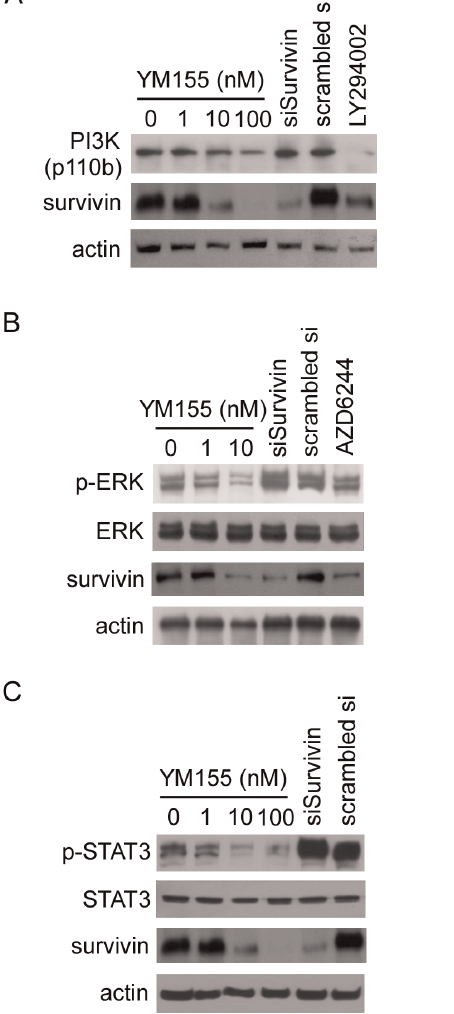
Figure 2. YM155 induces downregulation of PI3K, p-ERK, and p-STAT3 in PANC-1 cells. A, Levels of PI3K and survivin were analyzed by Western blotting after treating with YM155 or 30 m M LY294002 (control) for 24 hours, and 48 hours after transfection with 40 nM siRNA. B, Levels of phosphorylated ERK and expression of survivin were determined by Western blotting after treating for 24 hours with YM155 or 500 ng of AZD6244, and 48 hours after transfection of 40 nM siRNA. C, Levels of phosphorylated STAT3 and expression of survivin were analyzed by Western blotting after a 24- hours treatment with YM155 and 48 hours after transfection of 40 nM siRNA.